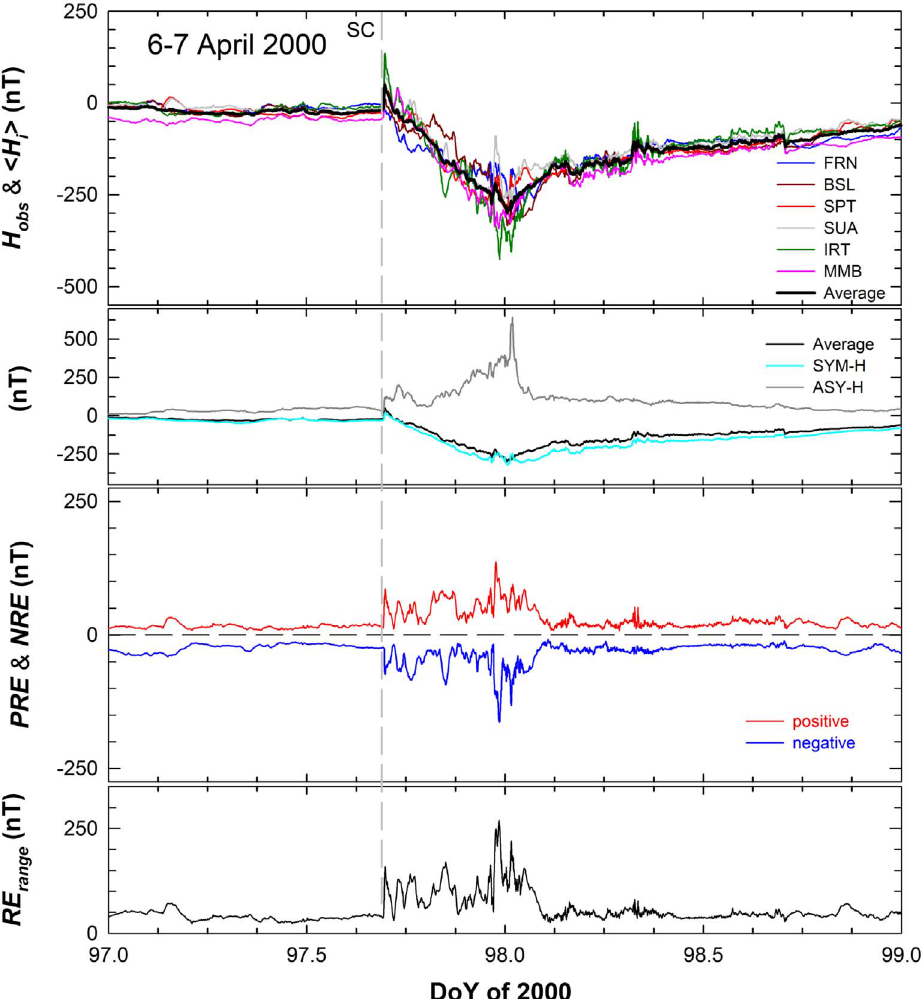
Fig. C.1. The event on 6 – 7 April 2000 (event #1). Top panel: Magnetic disturbance, H obs , at the six mid-latitude observatories (in colors) and the average of the disturbance, h H i i (in black); Second panel: h H i i (in black), SYM-H index (in cyan) and ASY-H index (in dark gray); Third panel: Positive (red) and Negative (blue) Residual Envelopes; Bottom panel: Residual range obtained as the difference between the Positive and Negative Residual Envelopes. Grey dashed line marks the SSC in the period